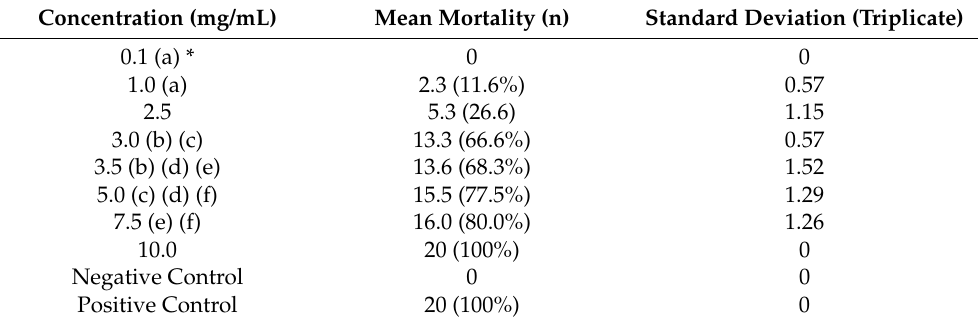
Table 2. Mean number of mortalities of A. aegypti larvae (L4) in different concentrations of Crude Ethanolic Extract (CEE) of H. velutina